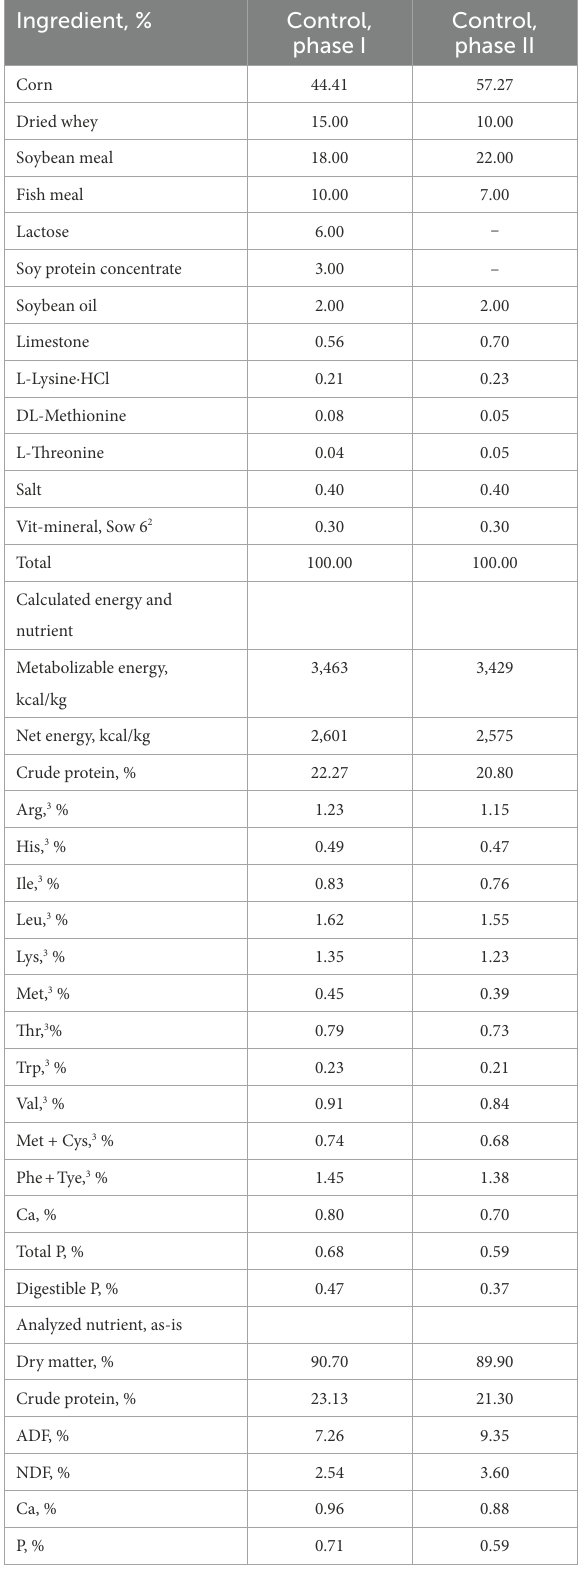
TABLE 1 Ingredient compositions of experimental diets 1